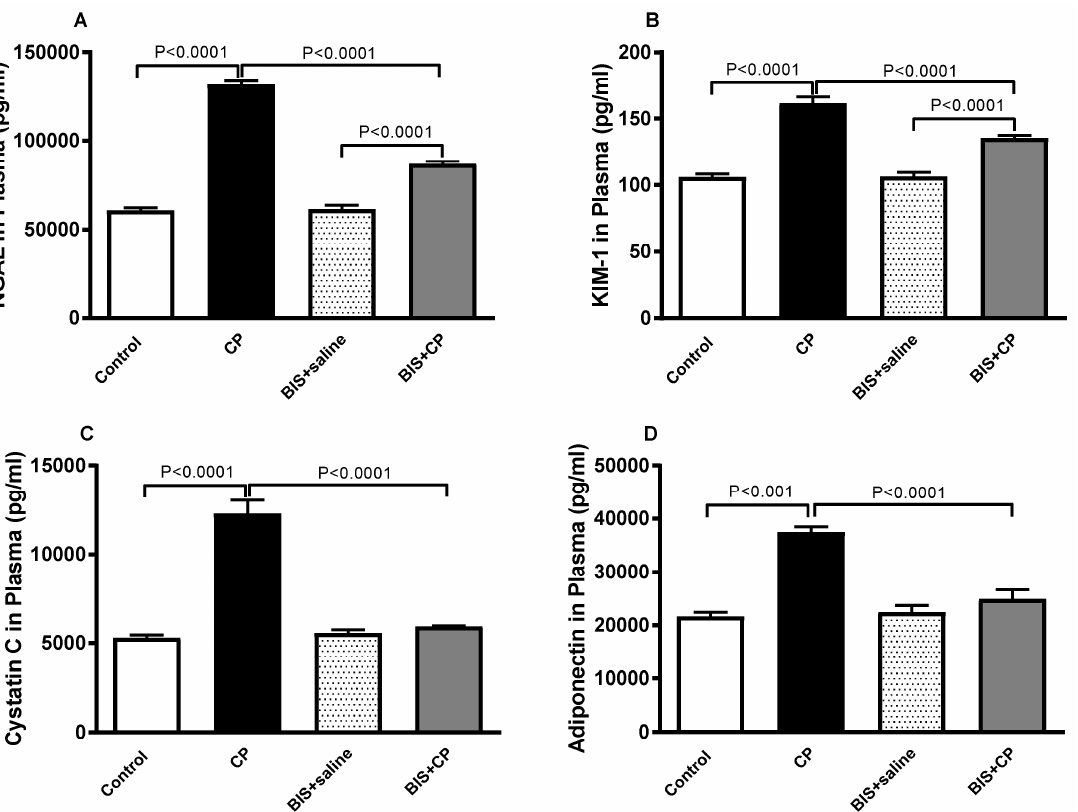
Figure 4. Plasma levels of neutrophil gelatinase-associated lipocalin (NGAL, ( A )), kidney injury molecule-1 (KIM-1, ( B )), cystatin C ( C ), and adiponectin ( D ) in mice treated orally with either sunflower oil (control) or bisabolol (BIS, 25 mg/kg) with or without cisplatin (CP, 20 mg/kg) given in- traperitoneally (n = 8). Mean ± SEM. Statistical analysis by ANOVA 1 followed by Holm–Sidak’s test.